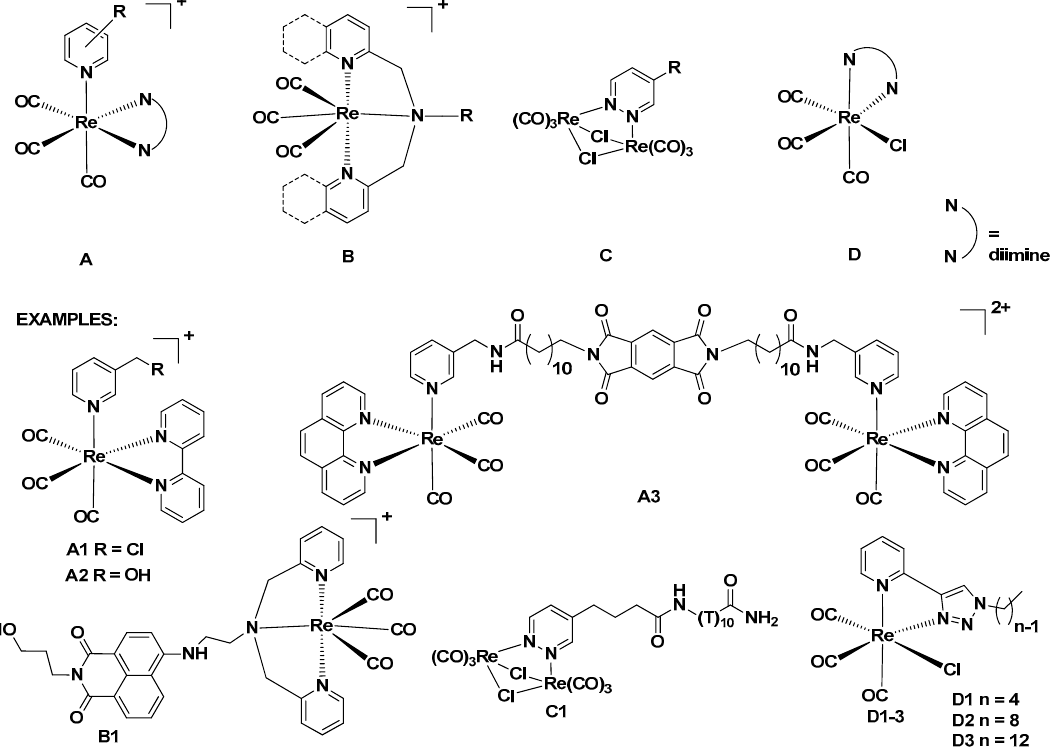
Figure 1. Basic structures of luminescent fac -{Re(CO) 3 } complexes for cell bioimaging and their examples. Four basic classes of luminescent bioprobes with fac-{Re(CO)3} cores (A–D).